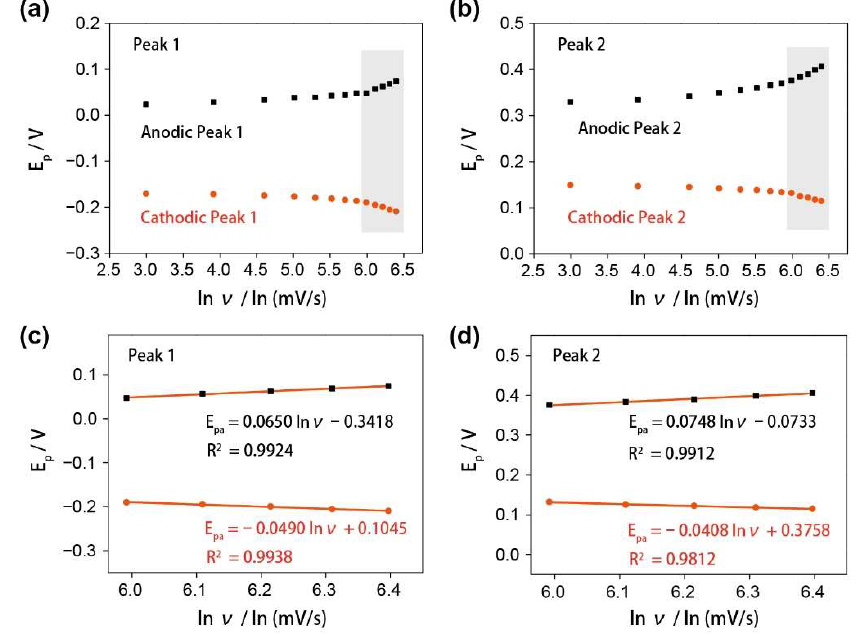
Figure 4. ( a ) Variations of E p vs. ln ν of the redox peak 1; ( b ) variations of E p vs. ln ν of the redox peak 2. ( c ) The calibration curves of E p vs. ln ν of the redox peak 1 when ν > 400 mV/s. ( d ) The calibration curves of E p vs. ln ν of the redox peak 2 when ν > 400 mV/s.